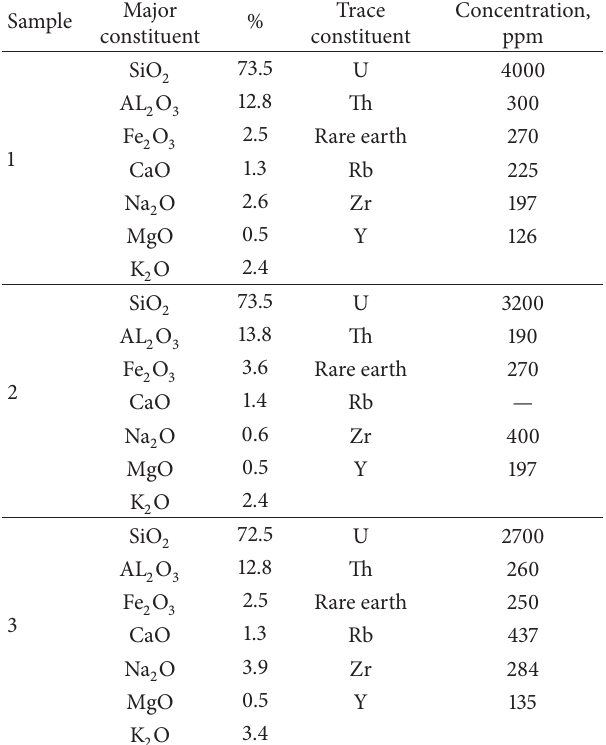
Table 5: Chemical analysis of granitic samples. Sample